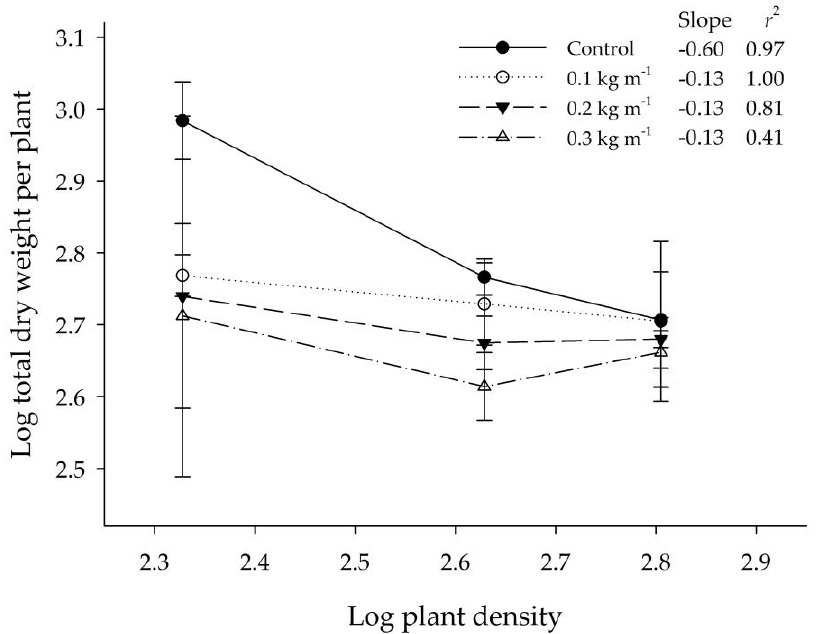
Figure 1. Relationship of log mean total dry weight and log plant density of C. rotundus ( CR ) for the residue of B. pilosa var. radiata ( BPr ) application at four different rates.